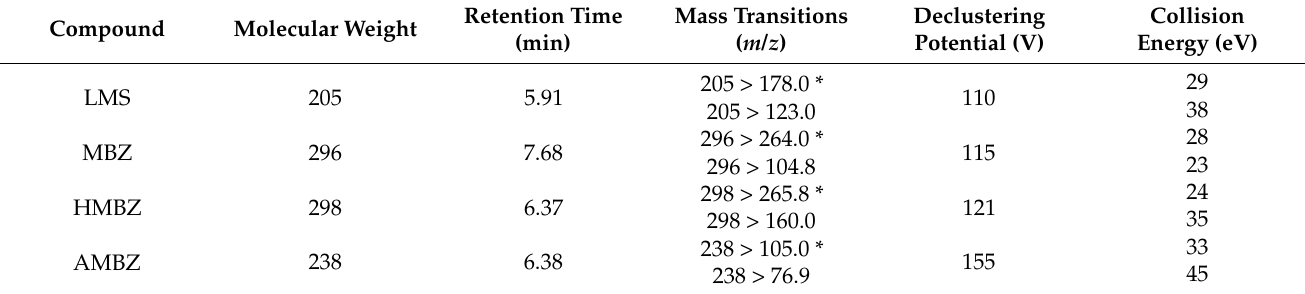
Table 2. HPLC–MS/MS conditions and retention times for LMS, MBZ, HMBZ, and AMBZ